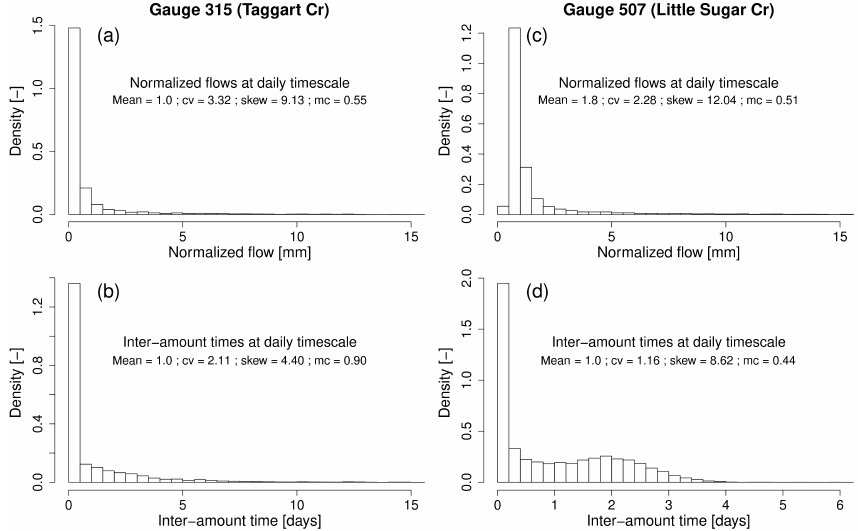
Figure 4. Histograms of flow time series (a) and time series of inter-amount times (b) for Taggart Creek and Little Sugar Creek at Archdale (LSugarA), for 24h scale. Table 3. Summary statistics of time series for flows and inter-amount times, at 24h sampling scale: coefficient of variation (CV), skewness (Skew) and medcouple